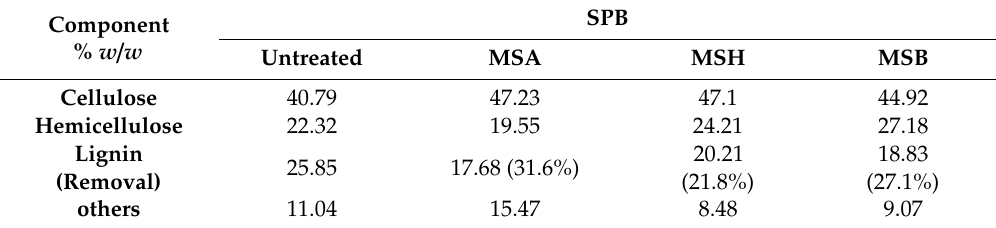
Table 2. The chemical composition of solids before and after pretreatment [4].